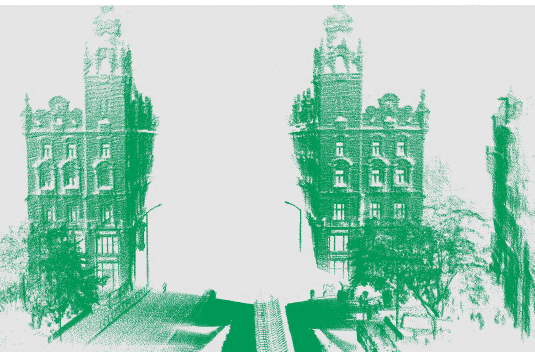
Figure 5: Tree crown detection (marked with